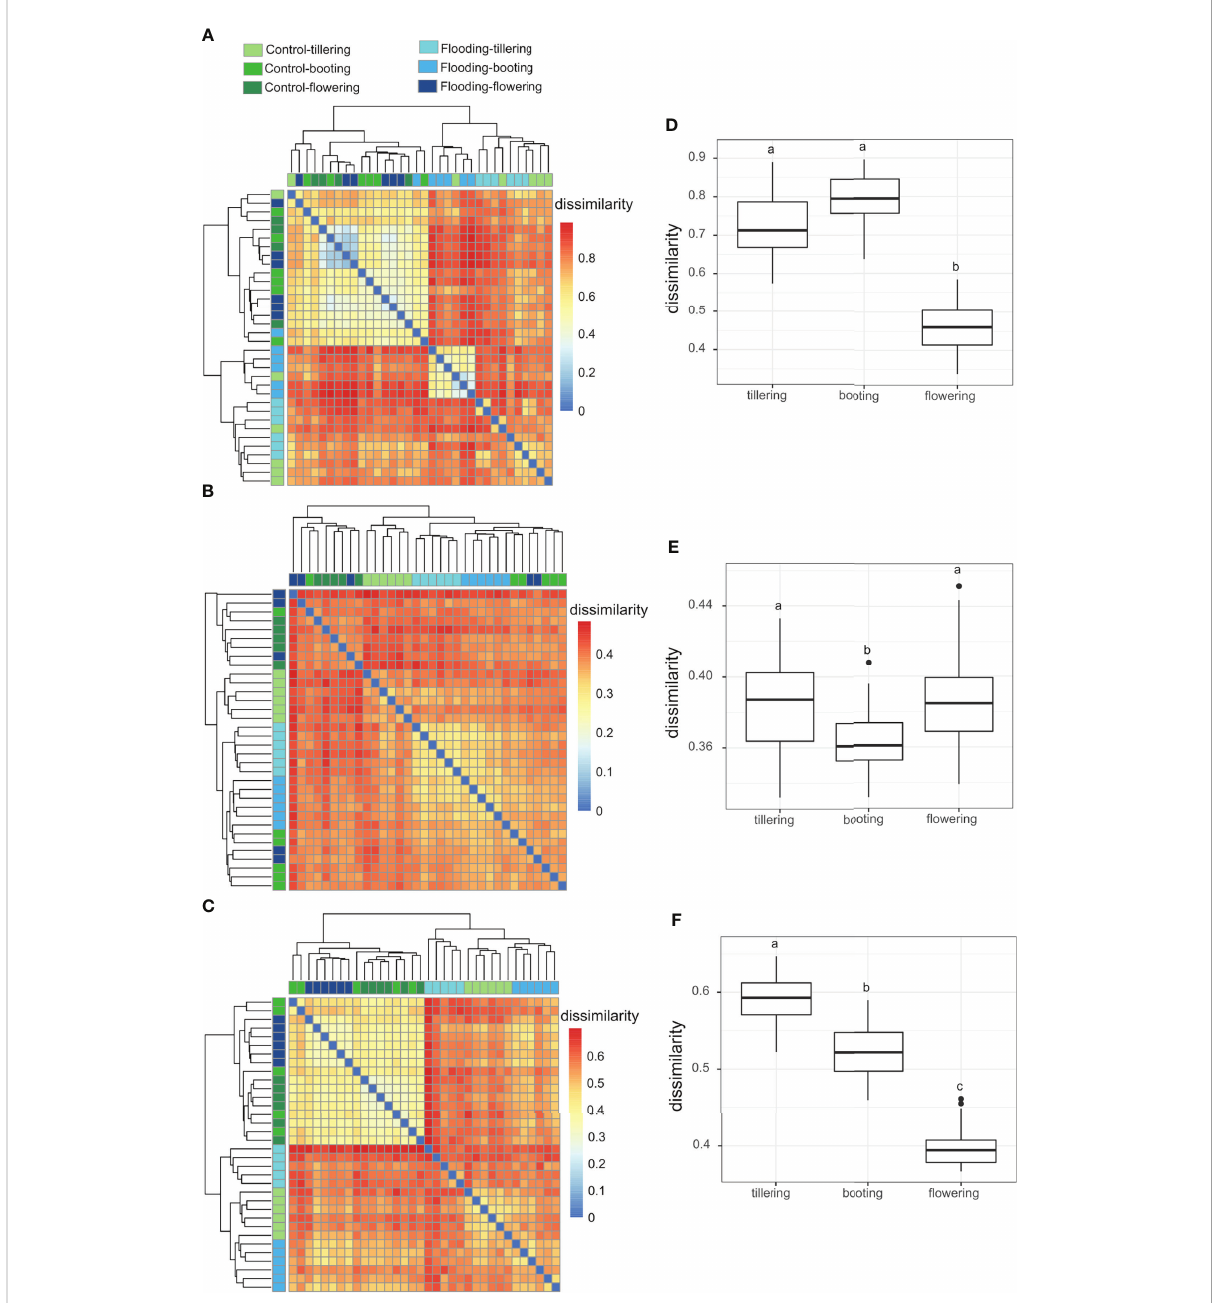
FIGURE 4 Heatmap representing the Bray-Curtis dissimilarity of mycobiota structure between watering treatment and plant growth stage (PGS) in the (A) leaf, (B) rhizosphere and (C) root compartments. Box plots of the Bray-Curtis dissimilarities between fl ooding and control samples at each PGS in the (D) leaf, (E) rhizosphere (F) and root compartments. The different letters indicate signi fi cant differences among PGS (Tukey ’ s HSD test P<